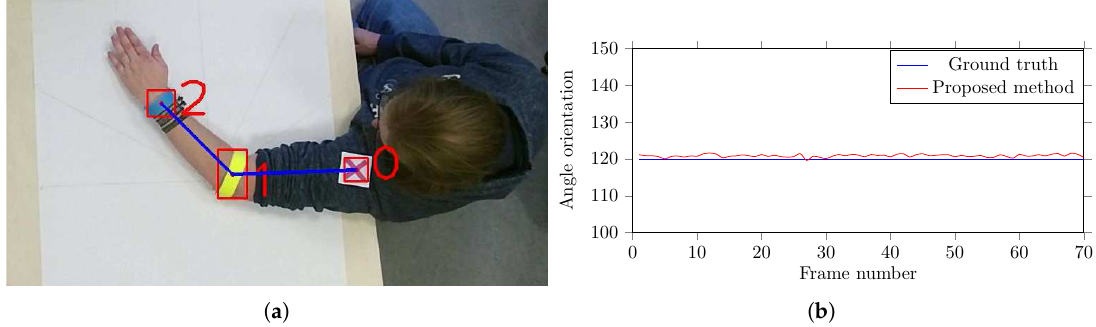
Figure 6. Validation of angle computation using a canvas with marked angle orientation. ( a ) The color markers are hooked-up to the arm of a proband, ( b ) the validation of computed angles at 120 ◦ .